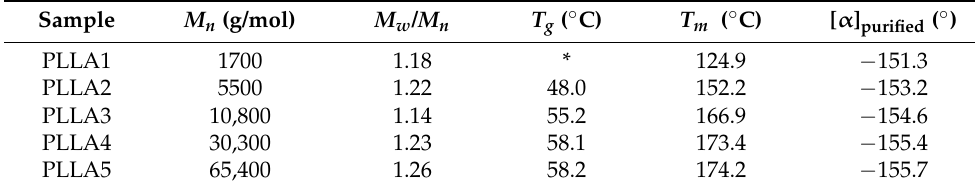
Table 1. Material properties of five PLLA